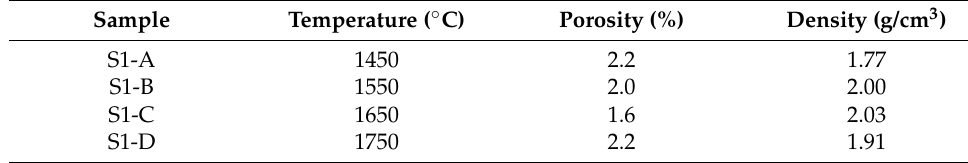
Figure 3. Polished cross-sectional and line scanning of the prepared inner layer with different temperature. ( a ) 1450 ◦ C; ( b ) 1550 ◦ C; ( c , d ) 1650 ◦ C; ( e , f ) 1750 ◦ C. Table 2. Properties of the prepared samples with different temperatures.